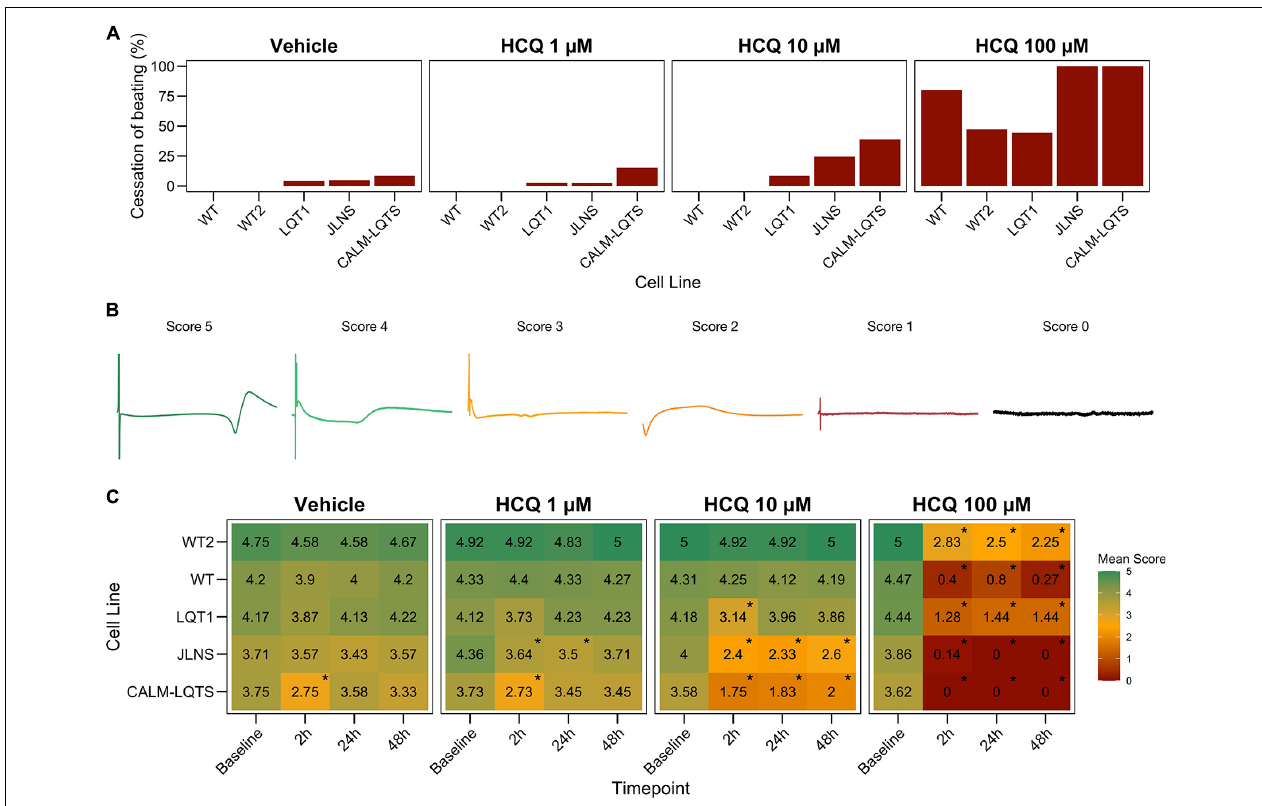
FIGURE 3 | (A) Percentage of MEAs that ceased to beat in at least one recording timepoint at different HCQ concentrations. (B) Representative examples of FPs with the associated score that were used to quantify the effect of HCQ on FP quality. (C) Mean FP scores at different HCQ concentrations and different timepoints in all the iPSC lines. The color code indicates the mean FP